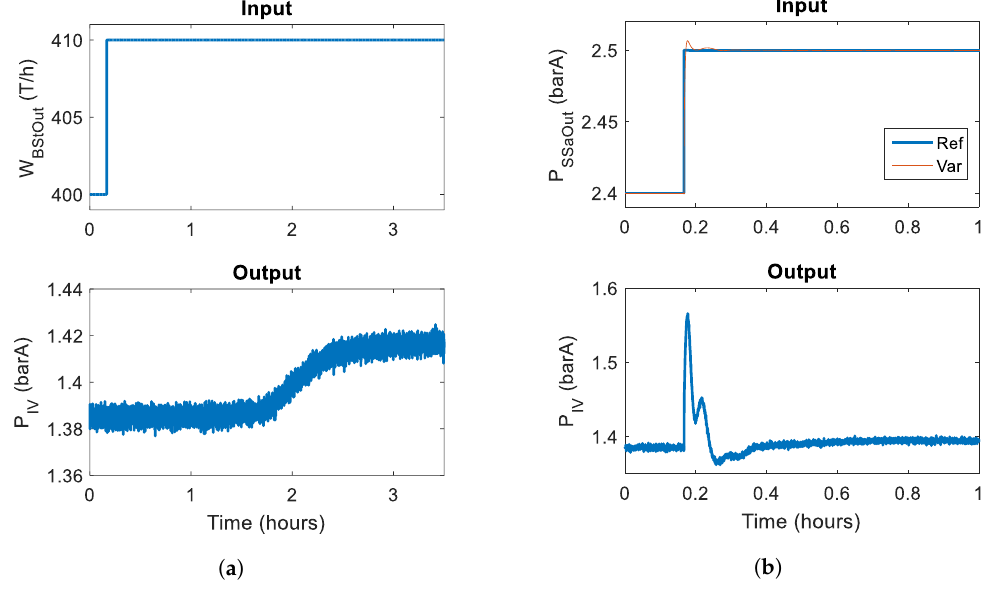
Figure 5. Dynamic response of P IV . ( a ) Dynamic response of P IV for a step in W BStOut ; ( b ) Dynamic response of P IV for a step in P SSaOut